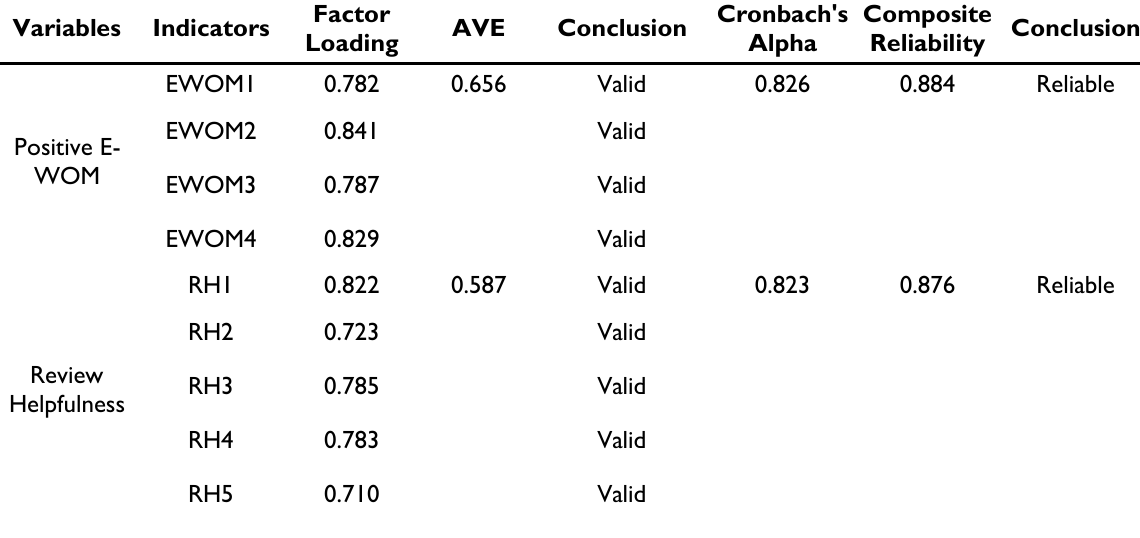
Table 3. Convergent Validity Testing